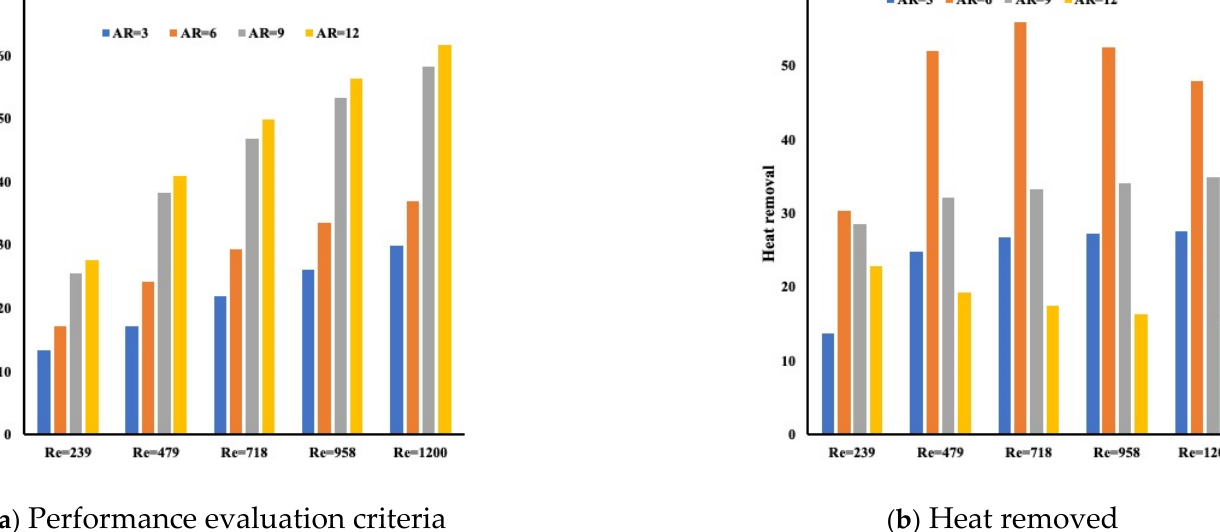
Figure 5. Performance indicator and heat removed for all cases (dp = 31